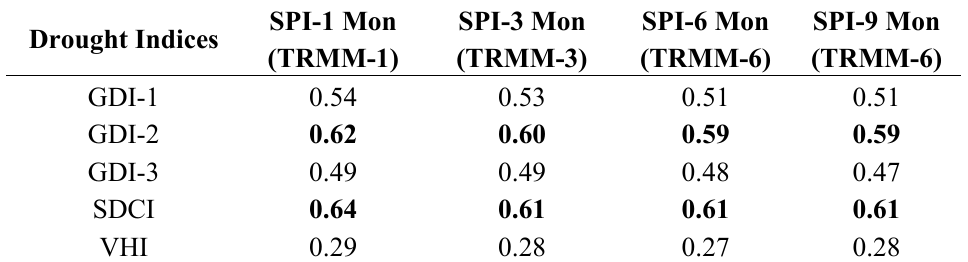
Table 4. The correlation coefficient (R) between the drought indices and the in situ SPI at multiple timescales (1, 3, 6 and 9 months). TRMM-1, TRMM-3, and TRMM-6 represent the monthly, three-month, and six-month TRMM precipitation data used in the drought indices,